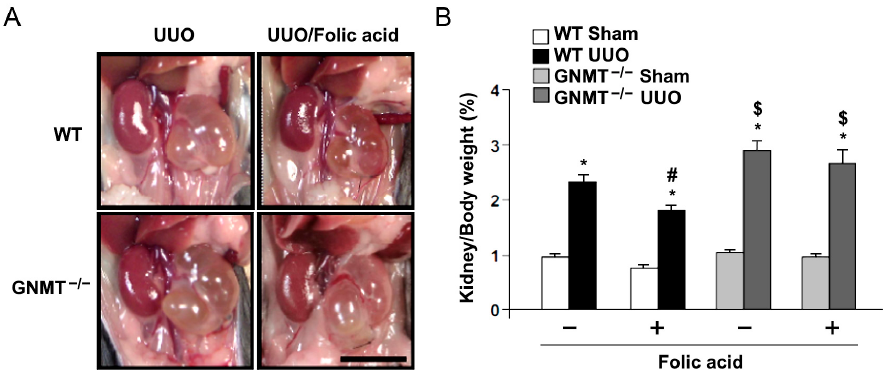
Figure 3. Effect of folic acid on UUO-induced hydronephrosis in WT and GNMT − / − mice. ( A ) WT and GNMT − / − mice underwent UUO and received folic acid for 14 days. At the end of the experiment, mice were euthanized by CO2 and the kidneys were then photographed. ( B ) Both sham and UUO- treated kidneys were harvested and weighed. The development of hydronephrosis was evaluated via normalization to body weight. The data are presented as means ± standard errors. * p < 0.05 versus the sham group, # p < 0.05 versus non-folic acid-treated mice, $ p < 0.05 versus WT mice.